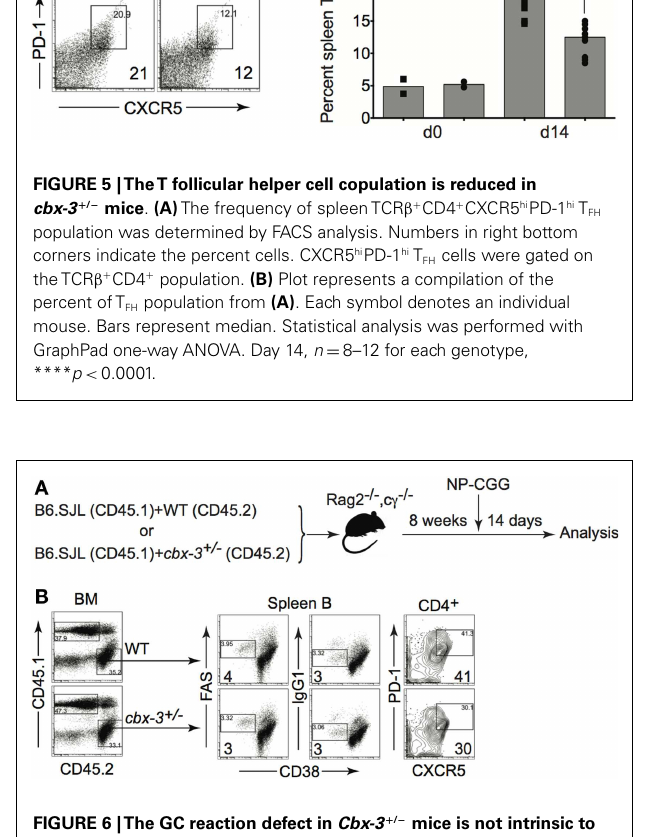
B6- Rag2 − / − C γ − / − andB6.SJLmicewerepurchasedfromTaconic.